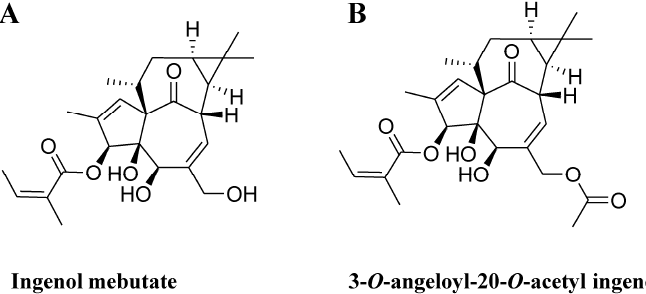
Figure 1. Chemical structures of ingenol mebutate ( A ) and 3- O -angeloyl-20- O -acetyl ingenol ( B ).